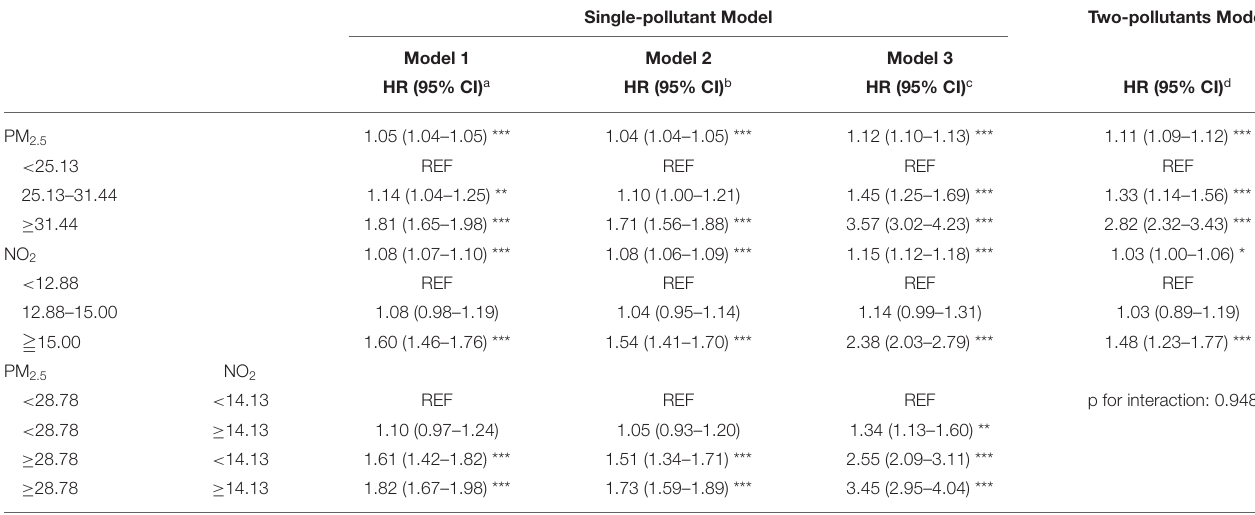
TABLE 2 | Association analysis and combination effects between PM 2.5 and NO 2 as well as